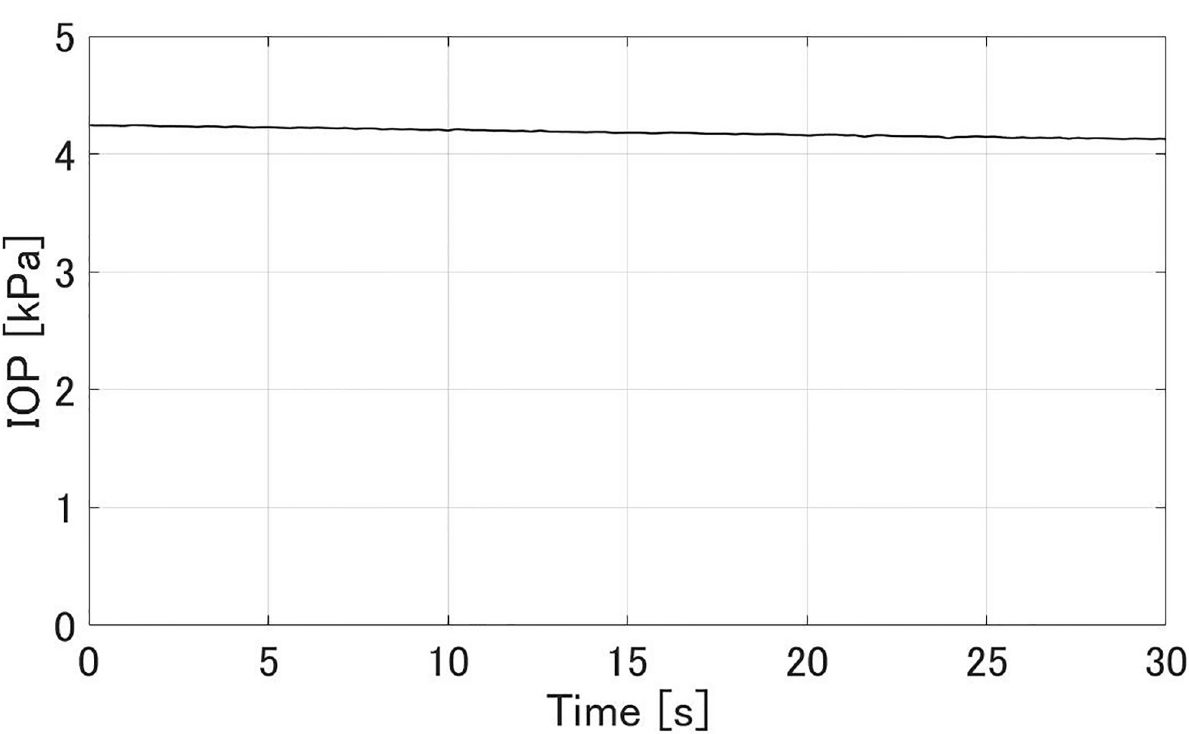
Fig 9. An experimental result of the IOP p − when simulating glaucoma. The sampling interval was 0.26 s. p − was 4.18 ± 0.06 kPa.